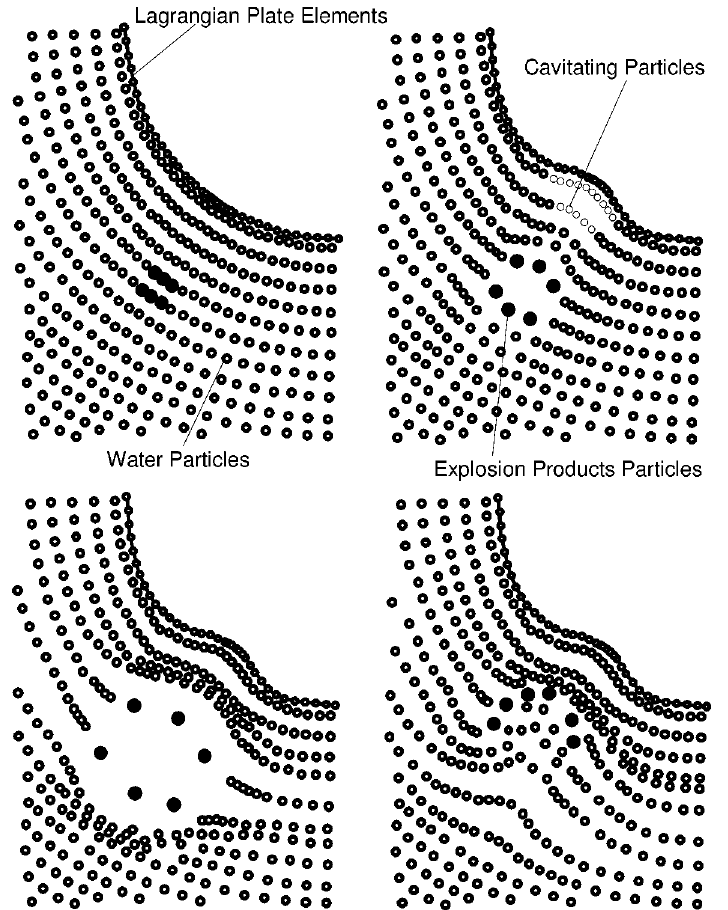
Fig. 3. SPH-Lagrangian hydrocode UNDEX-SMI